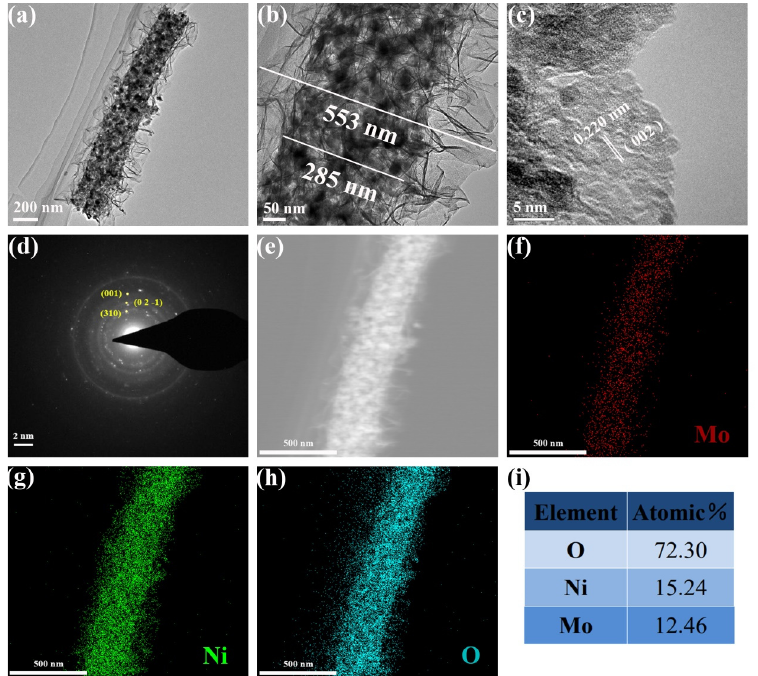
Figure 4. ( a – b ) TEM images, ( c ) HTEM image, ( d ) SAED pattern, ( e ) STEM, and ( f – h ) element mappings for Mo, Ni, and O of the NMH − 2 and the ( i ) elemental contents of Mo, Ni, and O of NMH − 2. Table 1. Elemental contents of the Mo, Ni, and O of NMO and NMH − 1, 2, 3. Element